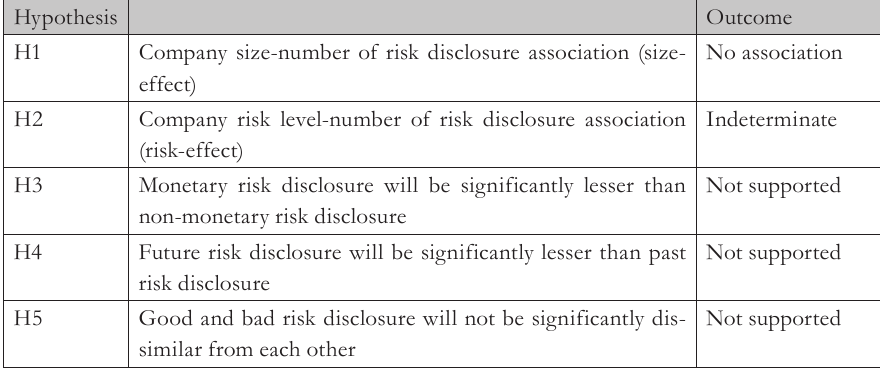
Tab. 5 – Summary of outcomes of hypothesis testing. Source: own